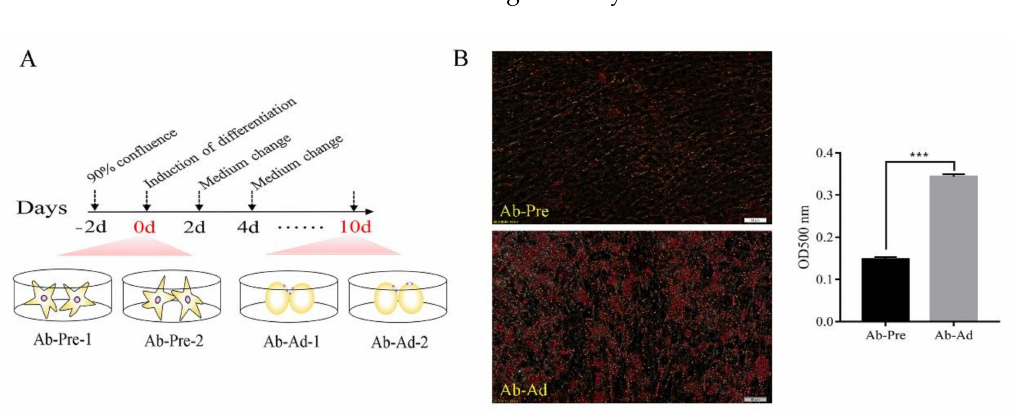
Figure 1. General description of the small RNA-seq data. ( A ) Procedure for inducing the di ff erentiation of abdominal cells. Cells were collected for RNA-Seq at day 0 (Ab-Pre) and day 10 (Ab-Ad). Each stage included two biological replicates. ( B ) Oil Red O staining of preadipocytes (0d) and adipocytes (10d). The data are demonstrated as the means ± SEM; *** means p <